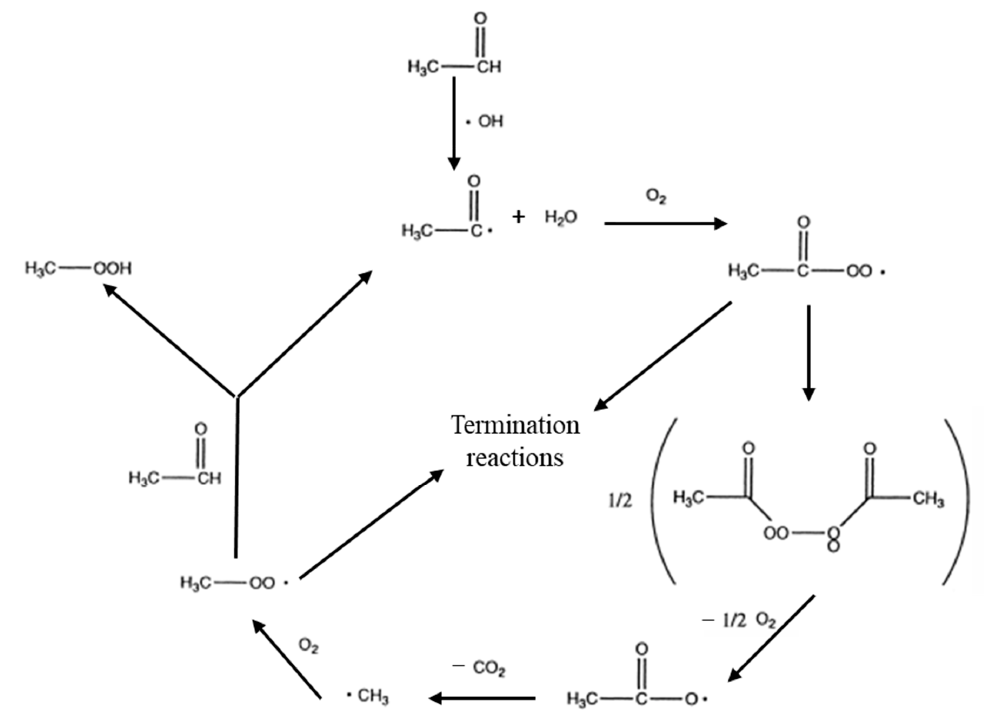
Figure 2. Schematic diagram of processes occurring during photocatalytic oxidation of acetaldehyde on an illuminated TiO 2 particle [10].